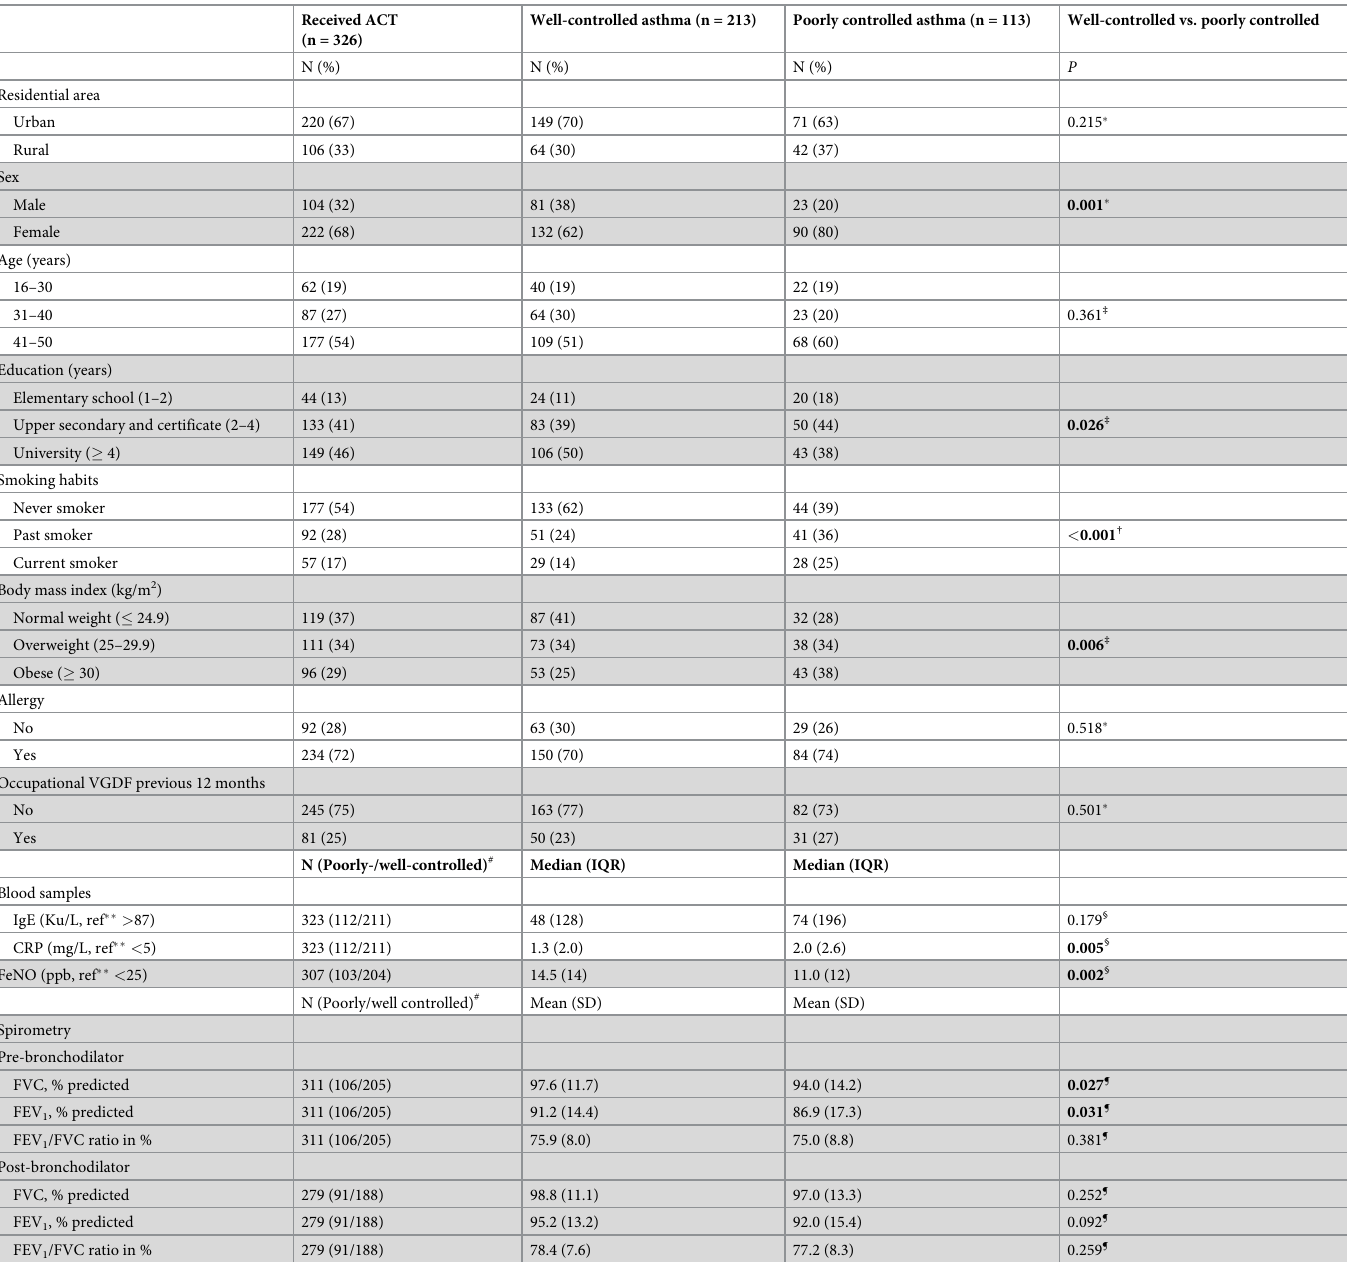
Table 1. Population